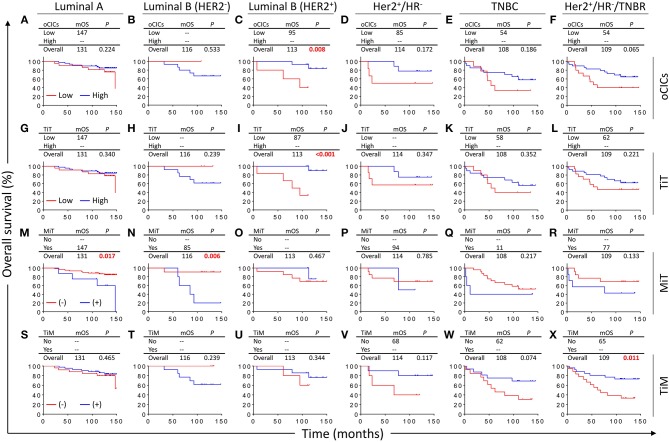
Survival impacts of subtyped cell-in-cell structures on different categories of breast cancers. Kaplan–Meier analyses of prognostic values of oCICs (A–F), TiT (G–L), TiM (M–R), and MiT (S–X) in five categories/subtypes of breast cancer. High for CICs ≥ 15/core, low for CICs < 15/core; (–) and (+) for cores negative or positive for CICs, respectively.